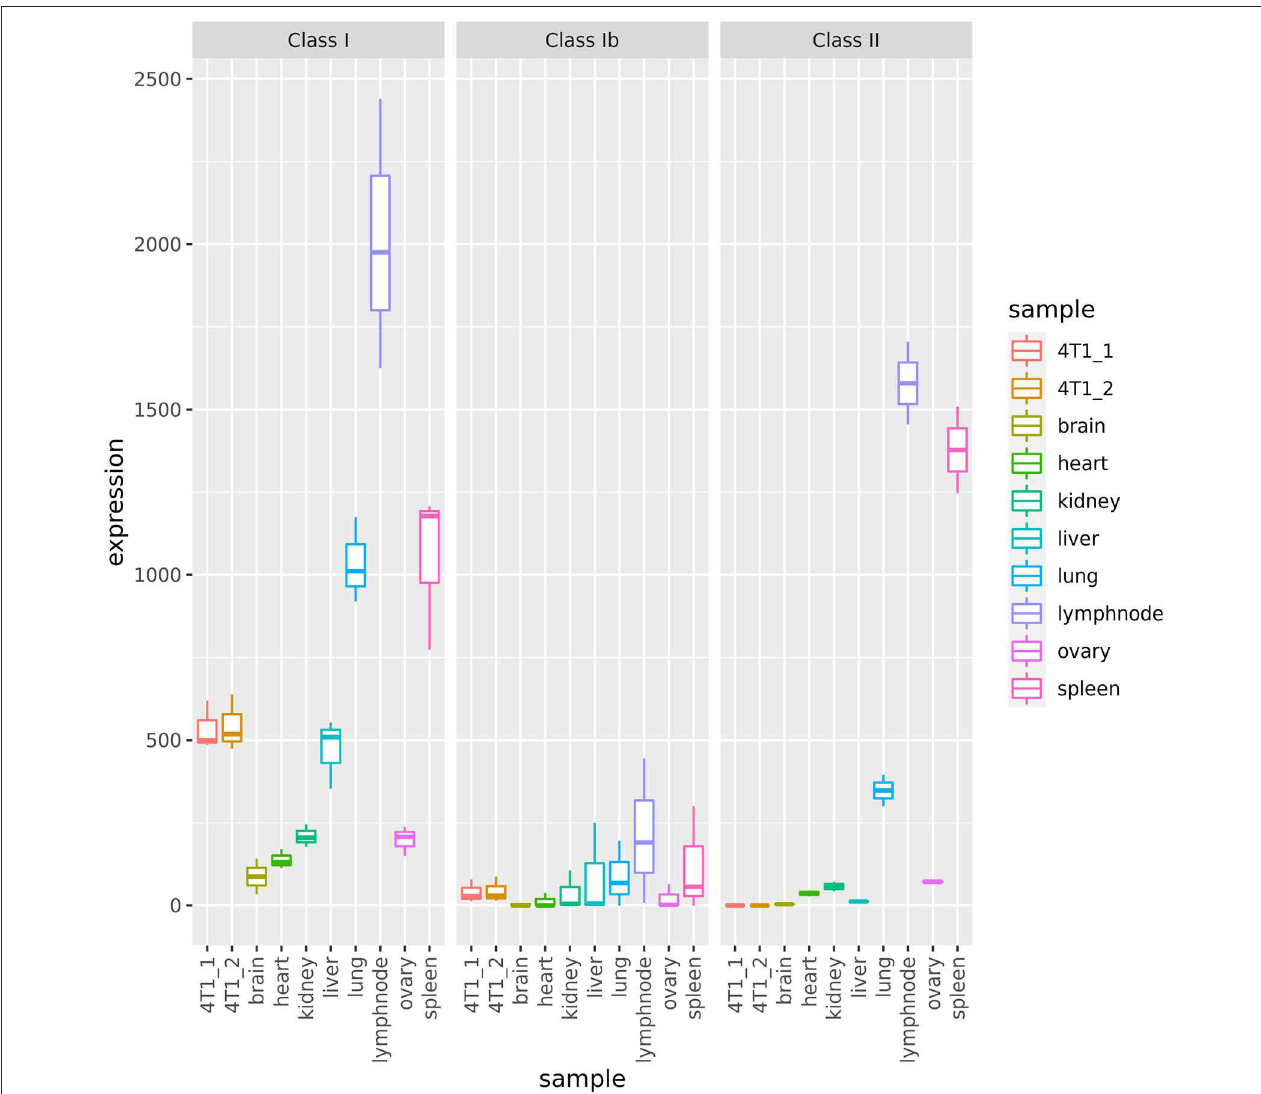
FIGURE 3 | Expression of MHC genes in 4T1 cells and Balb/C tissue samples. 4T1_1 and 4T1_2 indicate the duplicate 4T1 RNA-Seq